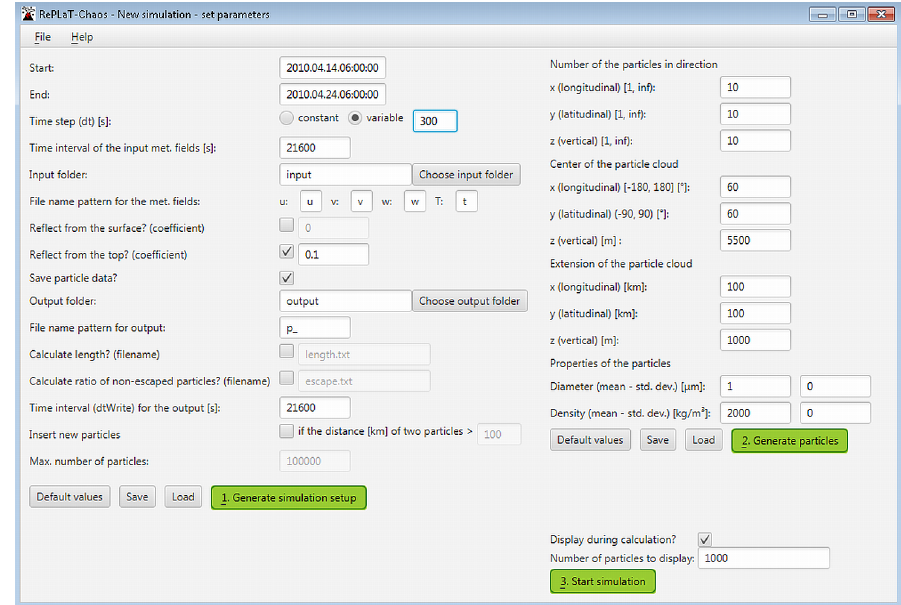
Figure A1. New simulation—set parameters. Starting a new simulation by setting the parameters of the simulation and the pollutant